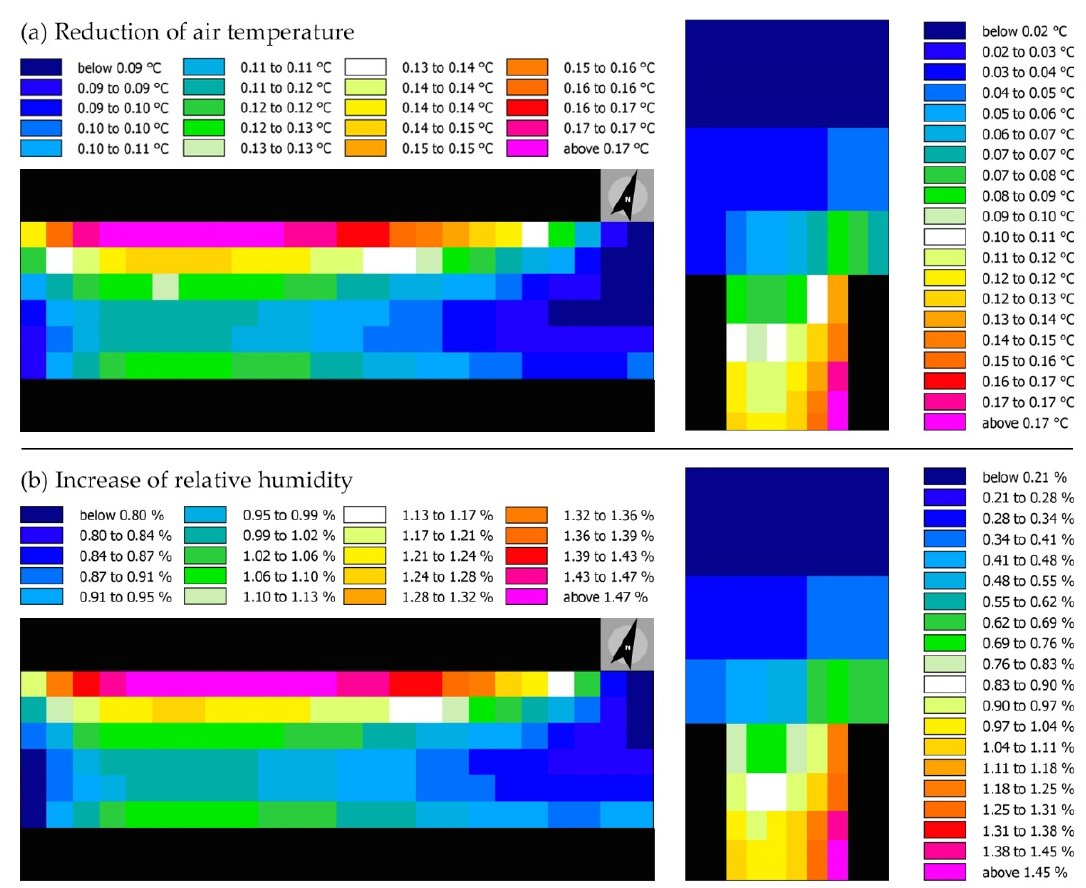
Figure 13. Variation of the external air temperature (°C) ( a ) and the relative humidity (%) ( b ) for canyon number 1, due to the GW.2 measure, considering the plan (on the left) and the section (on the right) views.